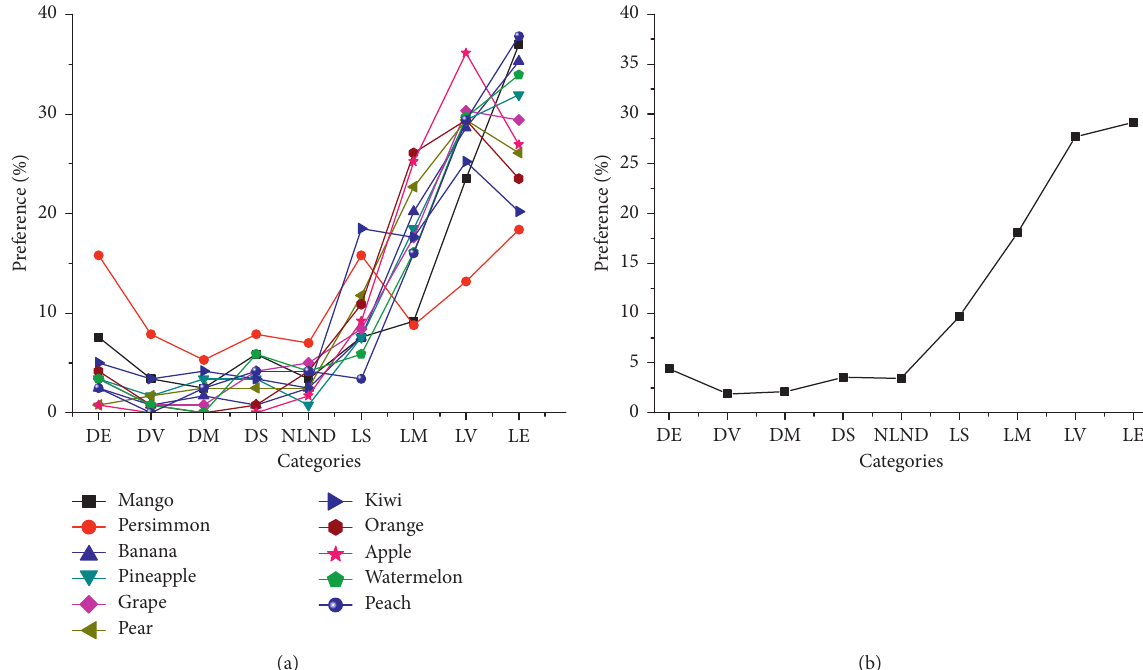
Figure 13: Food preference results. (a) Each fruits group food. (b) Fruits group as a whole.